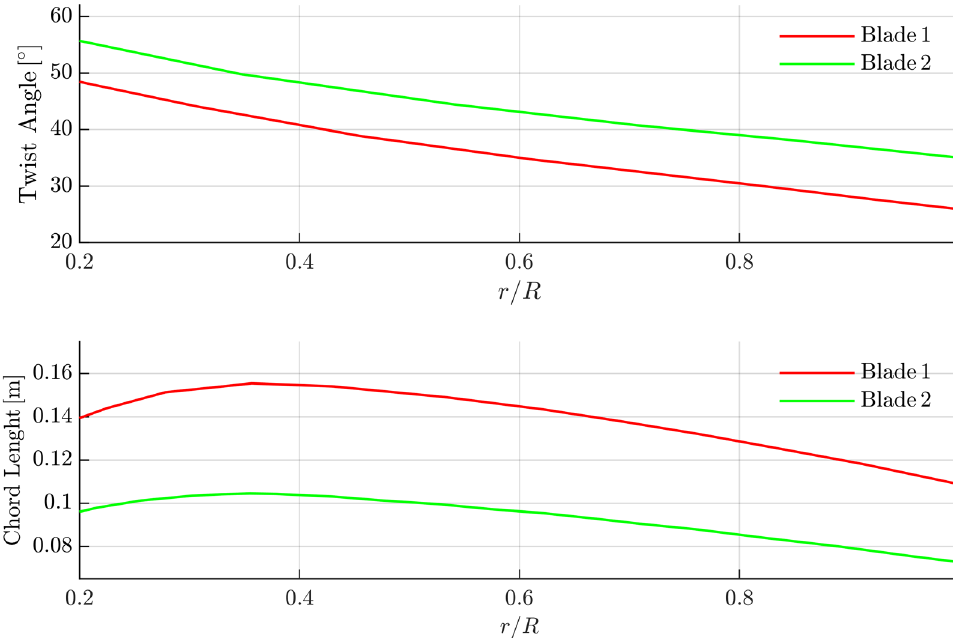
Figure 5. The profile parameters distributions of the two blades. Table 1. Performance comparison of the two blades in hovering